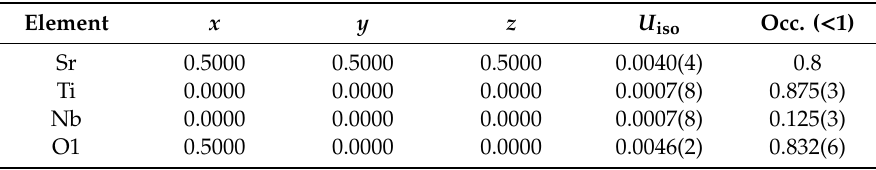
Table 2. Structural parameters after the Rietveld refinement of Sr 0.8 (Ti 0.9 Nb 0.1 )O 3-δ from NPD data at 25 °C in the Pm-3m space group, a = 3.91476 (3) Å, with  = 1.594 Å. Discrepancy factors: R p = 2.78%,